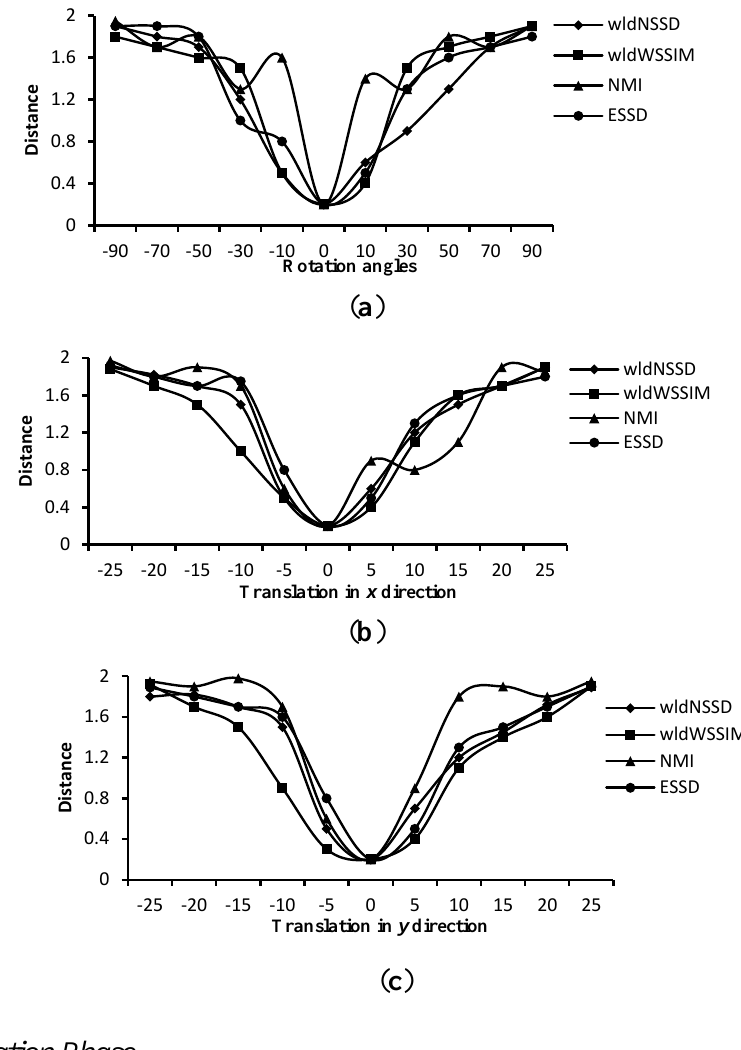
Figure 5. Distance measures for T1 and T2 weighted MR images. ( a ) Distance versus rotation angles; ( b ) Distance versus translation in x direction (mm); ( c ) Distance versus translation in y direction